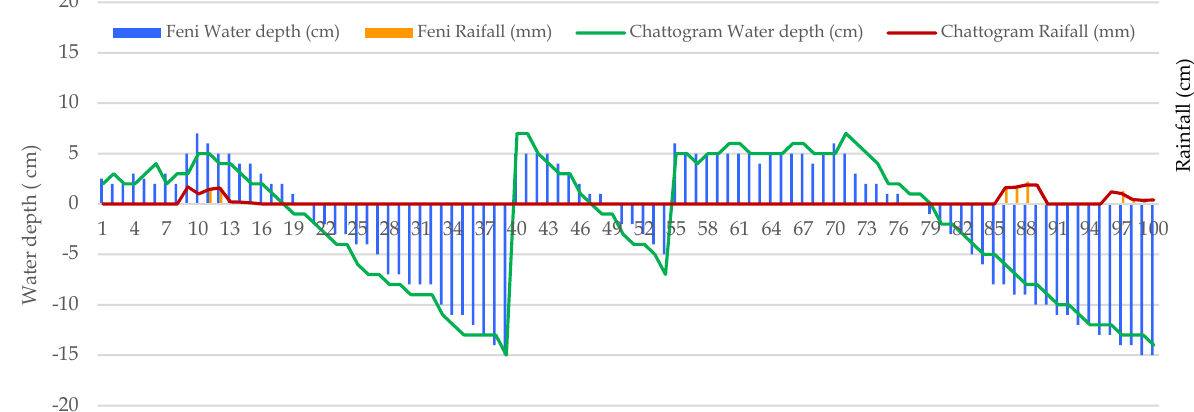
Figure 3. Schedule of AWD irrigation at different growth phases of rice.